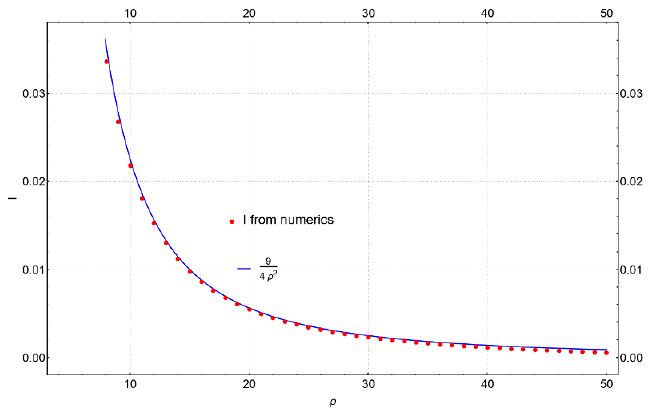
Figure 9 . The dependence of I ( (cid:26) )e (cid:0) 2 (cid:26) 2 = 3 =(cid:31) on (cid:26) for large (cid:26) , compared to the expectation